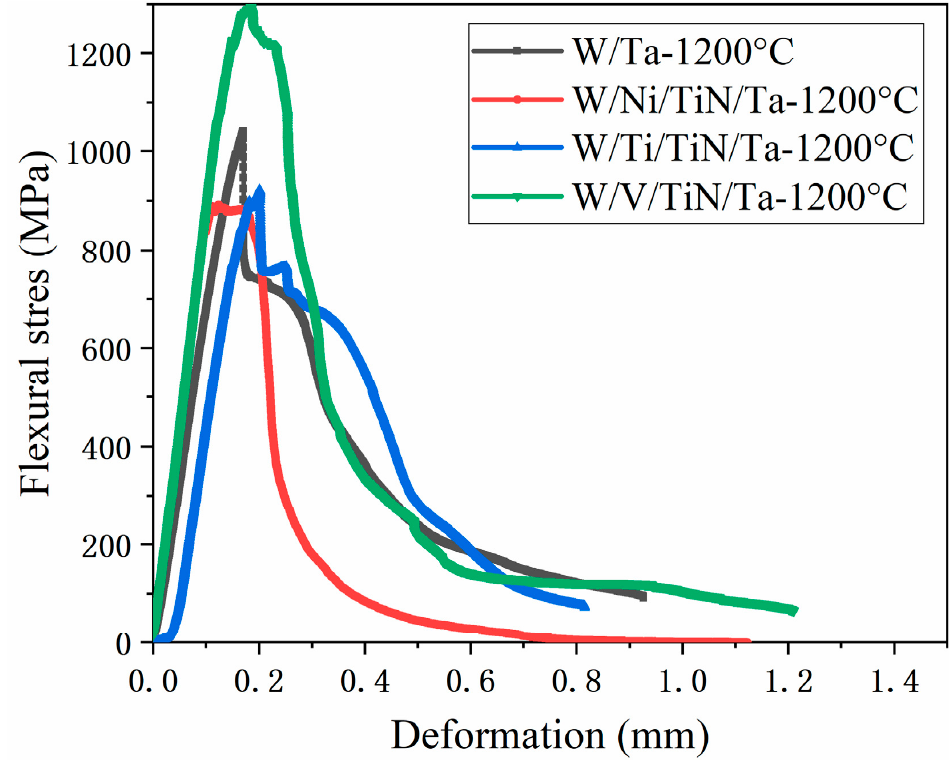
Table 6. Three-point bending properties of W/M/TiN/Ta composites as SPSed at 1200 °C.